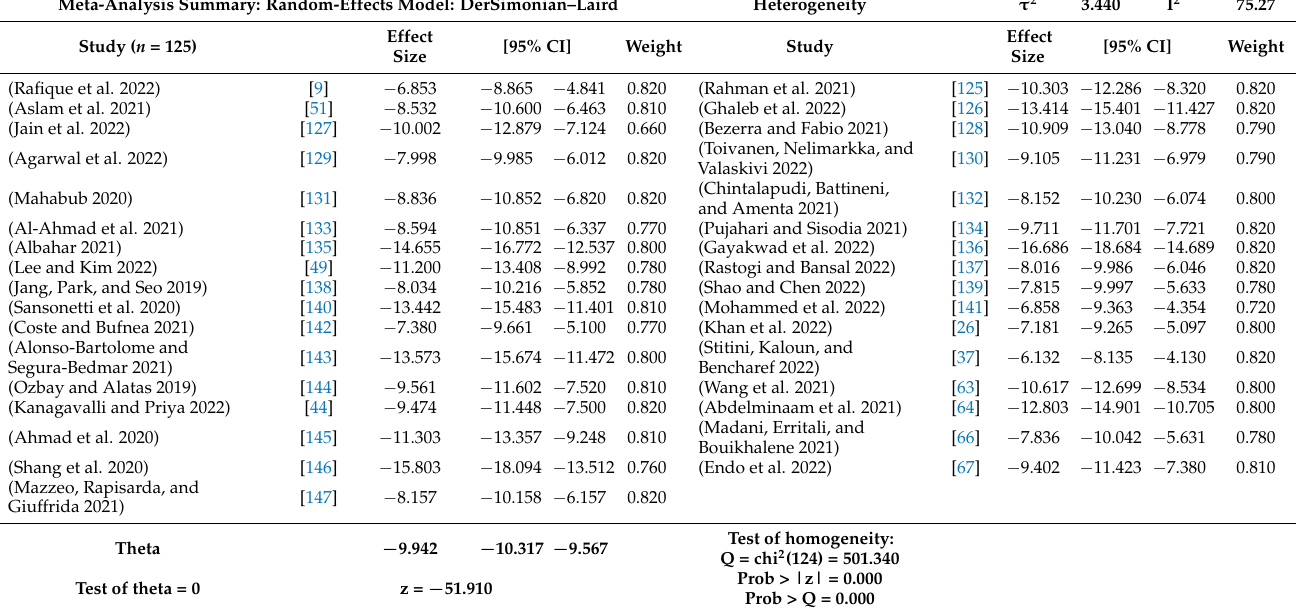
The Galbraith plot (Figure 3) shows a strong relationship between the sample size and the accuracy achieved by the model used, with the negative slope of the regression line further indicating that the accuracy reduces as the sample size increases. With only eight studies falling outside the 95% CI, this further supports high heterogeneity.